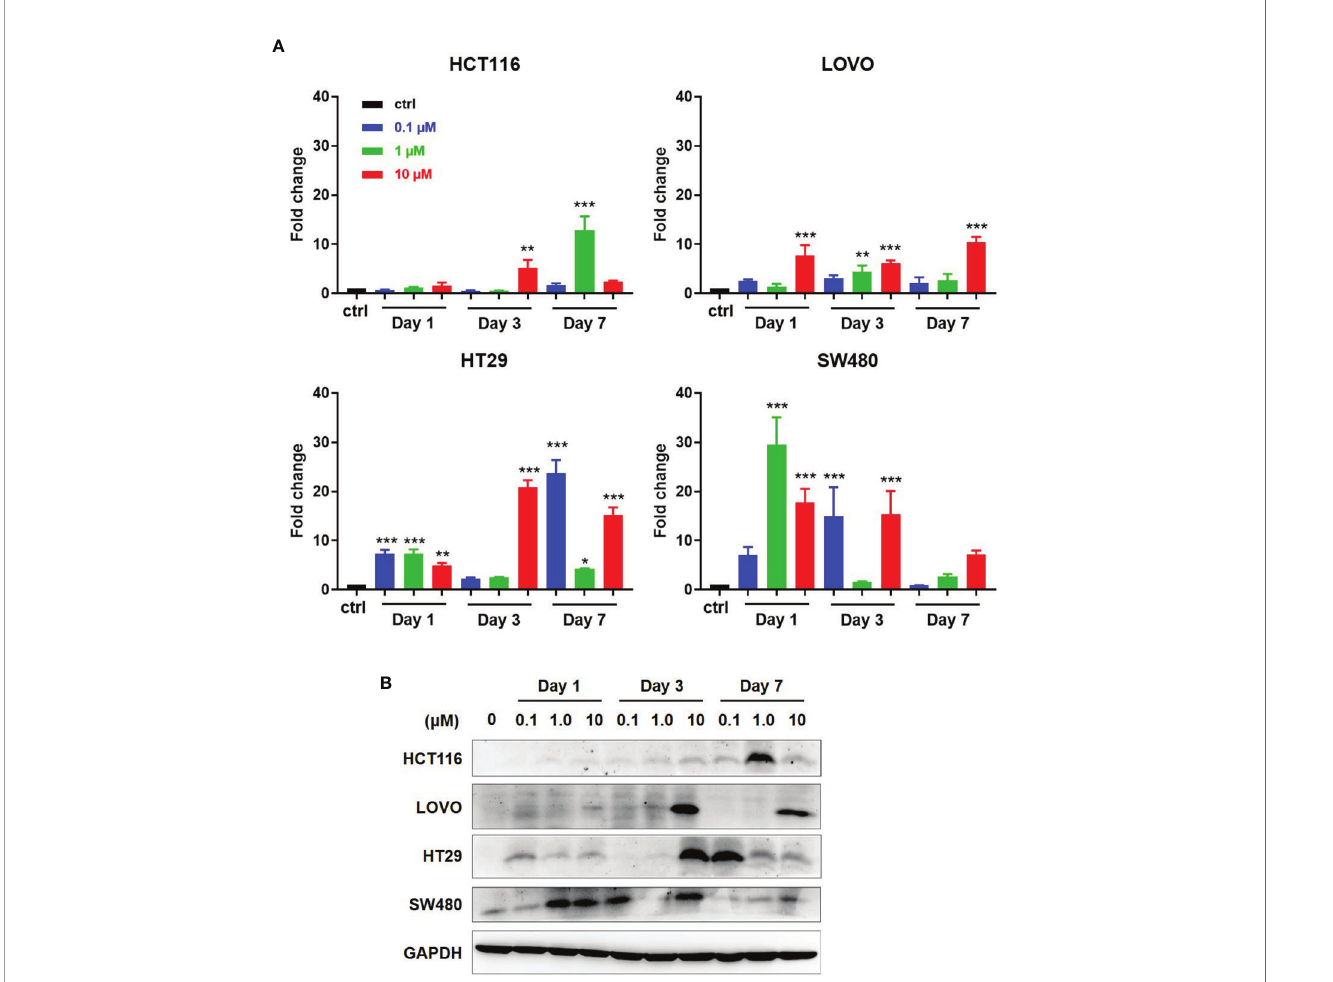
FIGURE 3 | Induction of antigen expression by DAC on CRC cell lines with MSI or MSS. (A) After exposed at various lengths of time and at various concentrations of DAC, NY-ESO-1 transcript expression in the indicated CRC cell lines, including LOVO and HCT116 with MSI-H, and SW480 and HT29 with MSS, was assayed by RT-qPCR. The results were normalized to GAPDH and the baseline of untreated groups (controls) was the mean value of one experiment performed in technical triplicate. The results of fold changes were analyzed in comparison to the DAC untreated group as control. * P <0.05, ** P <0.01, *** P <0.001. (B) NY-ESO-1 protein expression in the above cell lines was detected by Western blot assay. The proteins on the cell membranes were captured by the anti-NY-ESO-1 mAb (E976). GAPDH was used as a loading